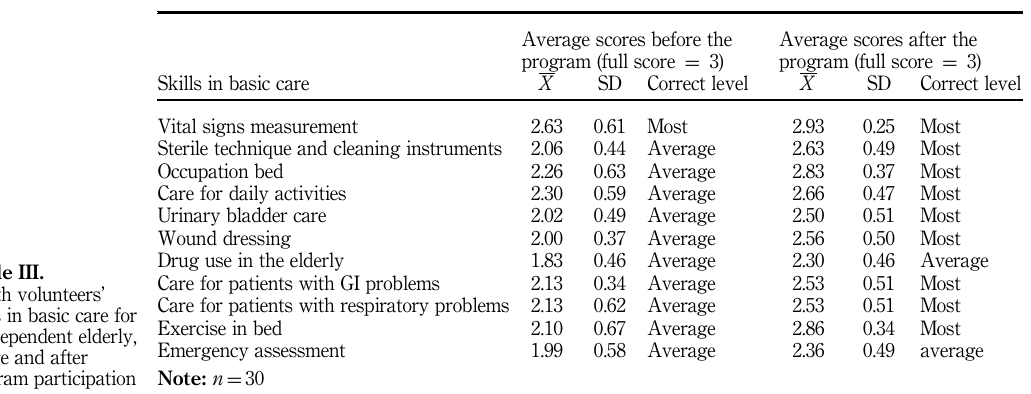
Table III. Health volunteers ’ skills in basic care for the dependent elderly, before and after program participation